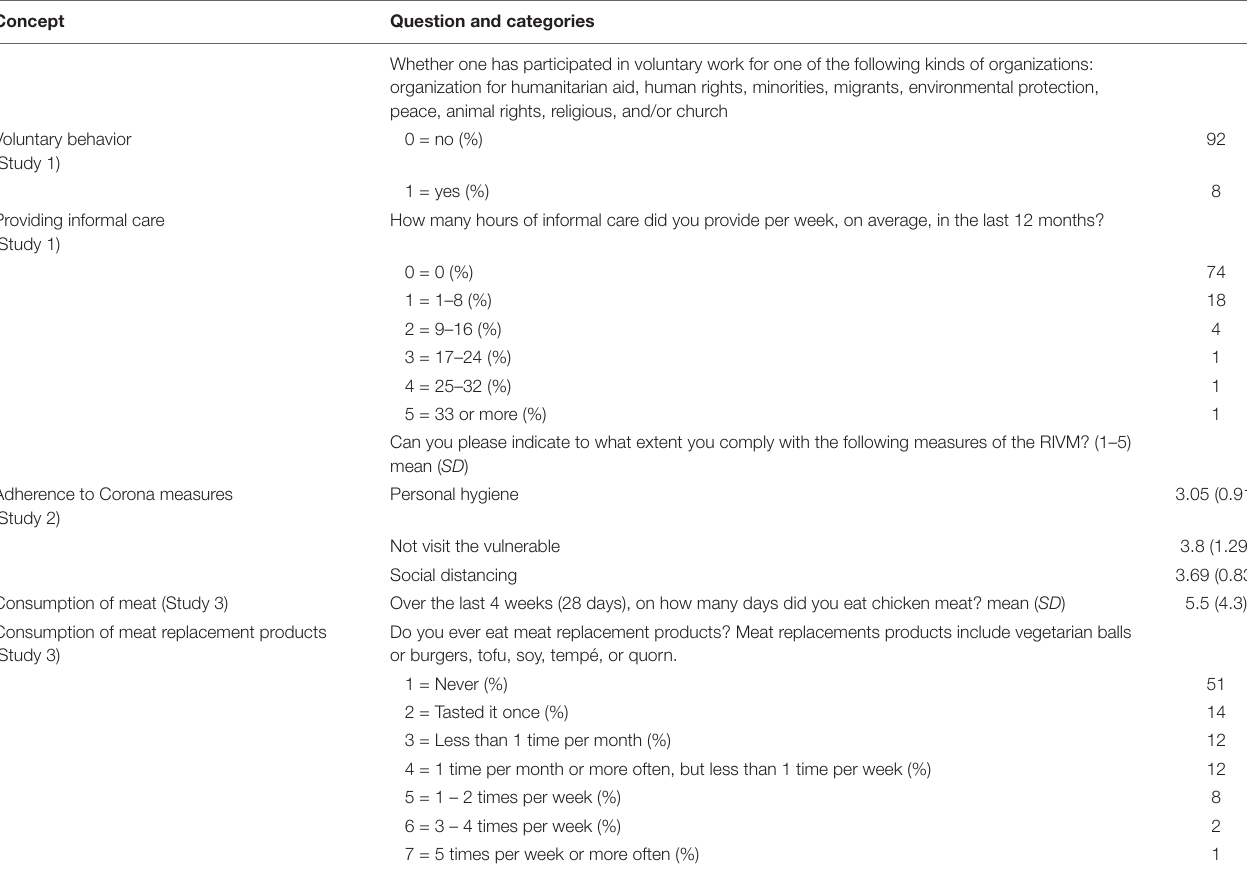
TABLE 3 | Descriptive statistics of the predicted morally relevant